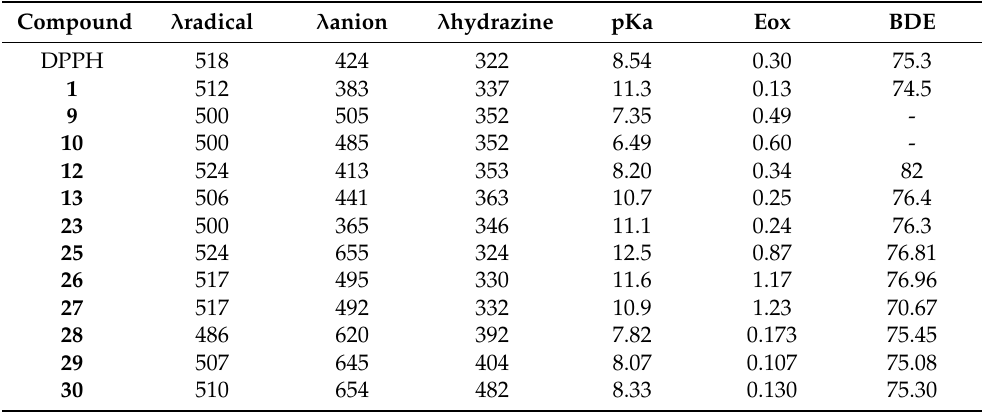
Table 2. λ max (nm), pK a , E ox (V) and bond dissociation energy (BDE) values (kcal/mol) for selected compounds [17,27,39,46,56,61]. Compound λ